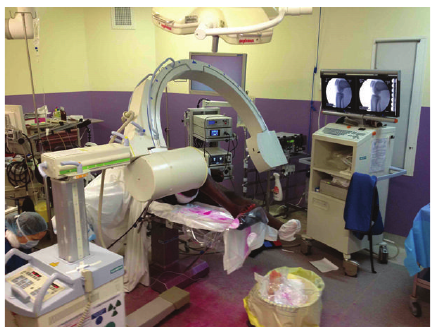
Figure 2: Installation of patient for fluoroscopy guided bicruciate reconstruction.